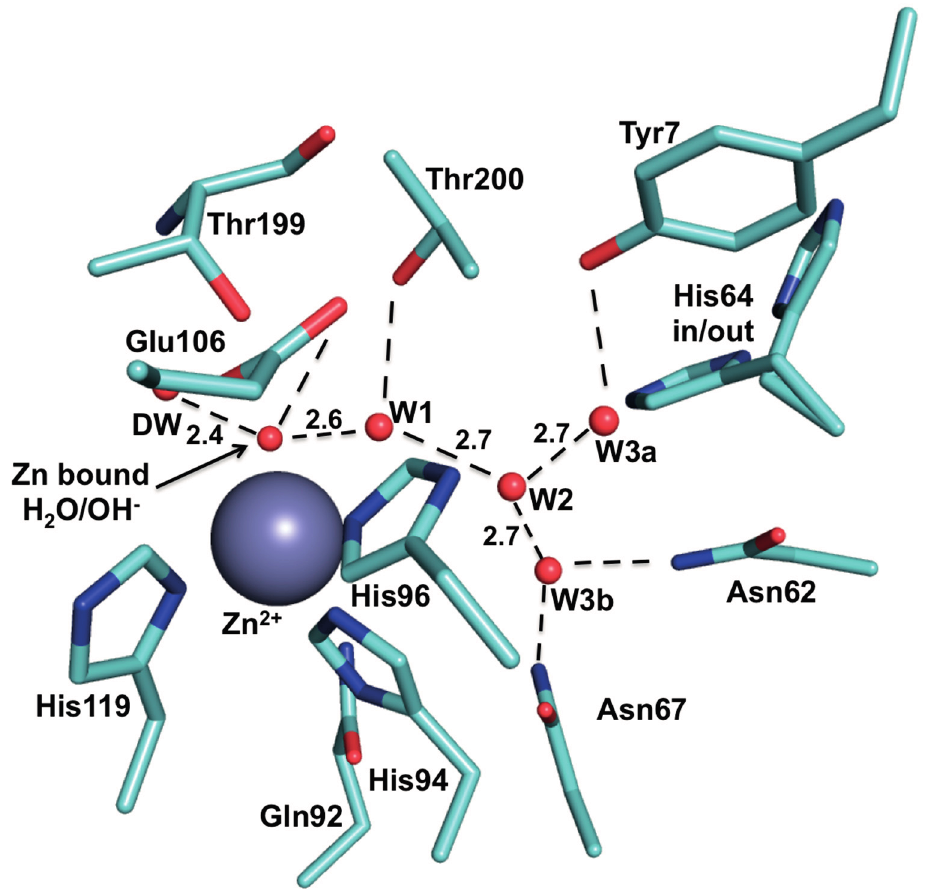
Figure 4. The active site of CA II (PDB ID: 3KS3). The zinc ion is represented by a grey sphere and is coordinated by His 94, 96 and 119, and a H 2 O/OH − molecule. The zinc bound H 2 O/OH − binds at a distance of 1.9 Å away from the zinc ion. Water (W) are represented by red spheres while hydrogen bonds (H-bonds, Å) are represented by dotted lines. This figure was made using PyMol